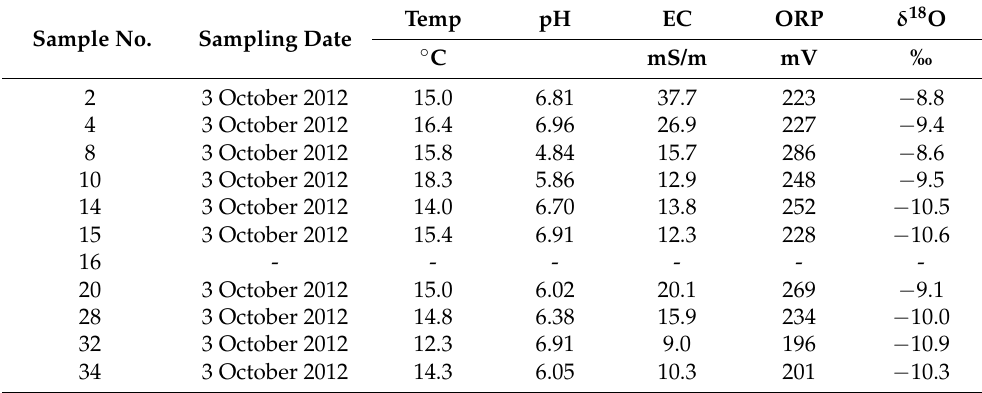
Table 8. Water temperature, pH, electric conductivity (EC), oxidation–reduction potential (ORP), and δ 18 O composition for groundwater samples in the Sho River alluvial fan on 3 October 2012.